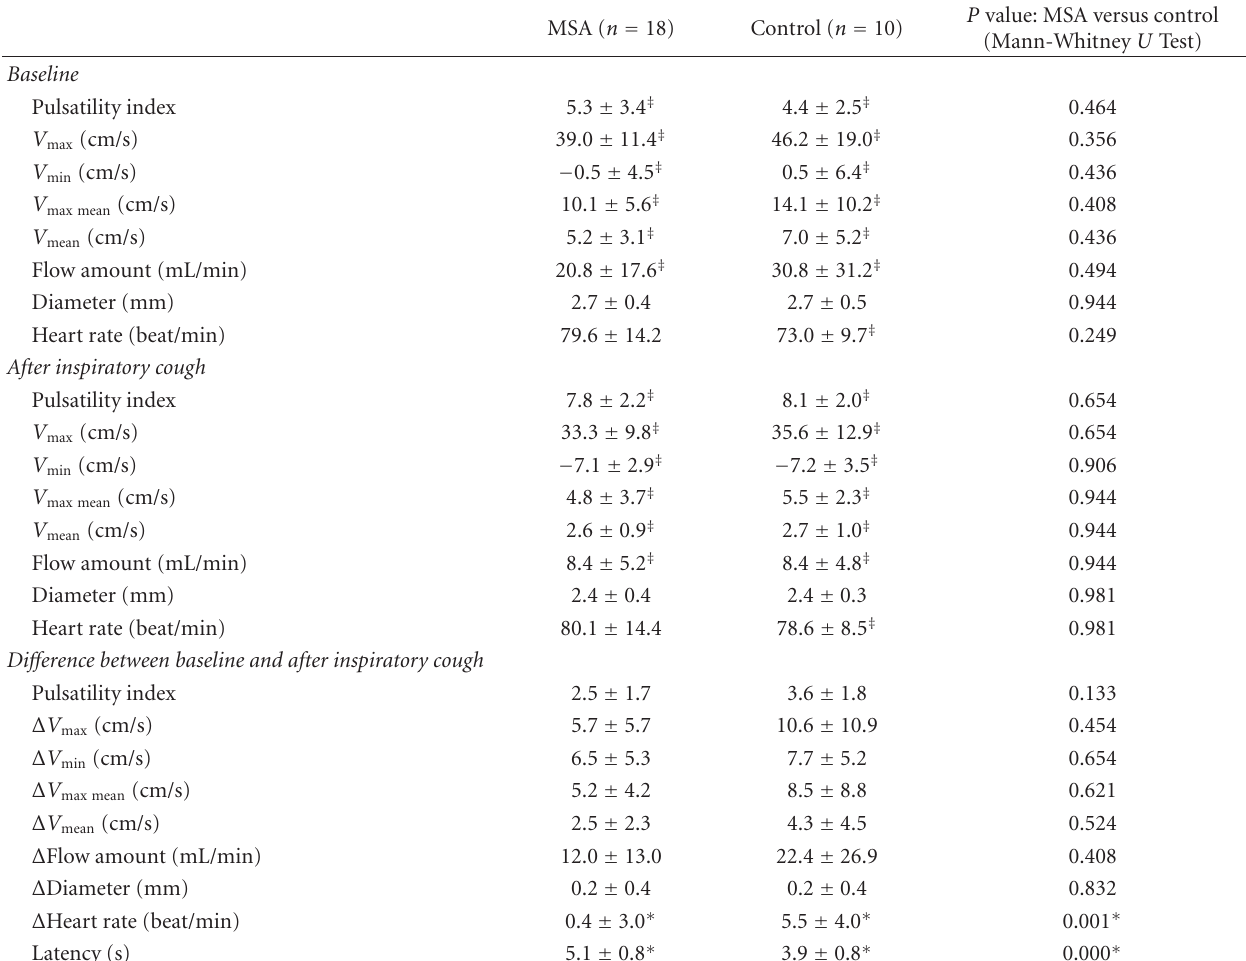
Table 2: The hemodynamic variables of sympathetic vasomotor response and their corresponding changes at baseline and after inspiratory